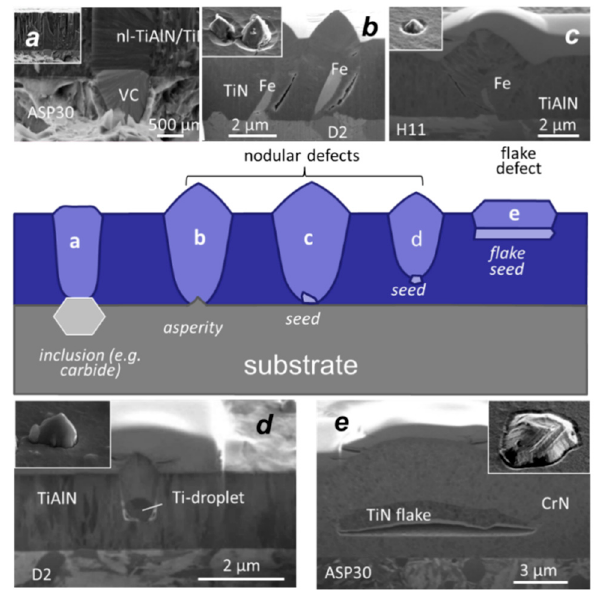
Figure 8. Three-dimensional (3D)-profilometry image of TiN coatings deposited on D2 tool steel substrate evaporation using thermionic arc ( a ), magnetron sputtering ( b ), and cathodic arc ( c ). The sharp peaks are the nodular defects while the blue dots are craters (pay attention to the strong exaggeration in z-scale).